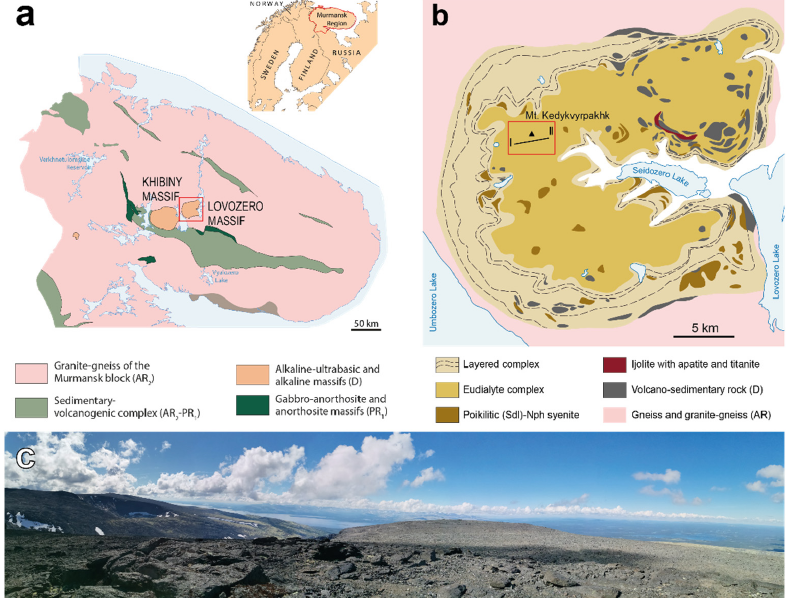
Figure 1. ( a ) General geological scheme of Kola Peninsula and location of the Lovozero massif within the red square; ( b ) geological scheme of the Lovozero massif and the location of Alluaiv- Kedykvyrpakhk eudialyte deposit within the red square, based on [3]; ( c ) The view from the top of the Kedykverpakhk Mt. to the Umbozero Lake side. The black line I–II represents the section of the Alluaiv